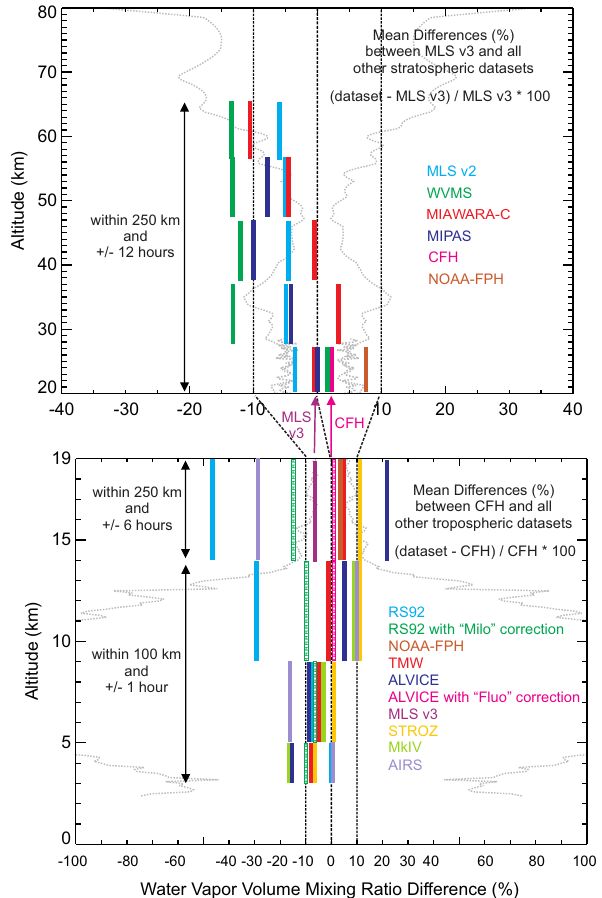
Fig. 20. Campaign-mean differences between all available datasets. CFH (respectively MLS v3) is taken as the reference in the tropo- sphere (bottom panel) (respectively, stratosphere, top panel). The grey dotted curves show water vapor variability (%) estimated from the standard deviations measured by CFH and MLS over the entire campaign. The top and bottom panels are purposely shifted hori- zontally to mitigate the 3–7% difference between the tropospheric and stratospheric